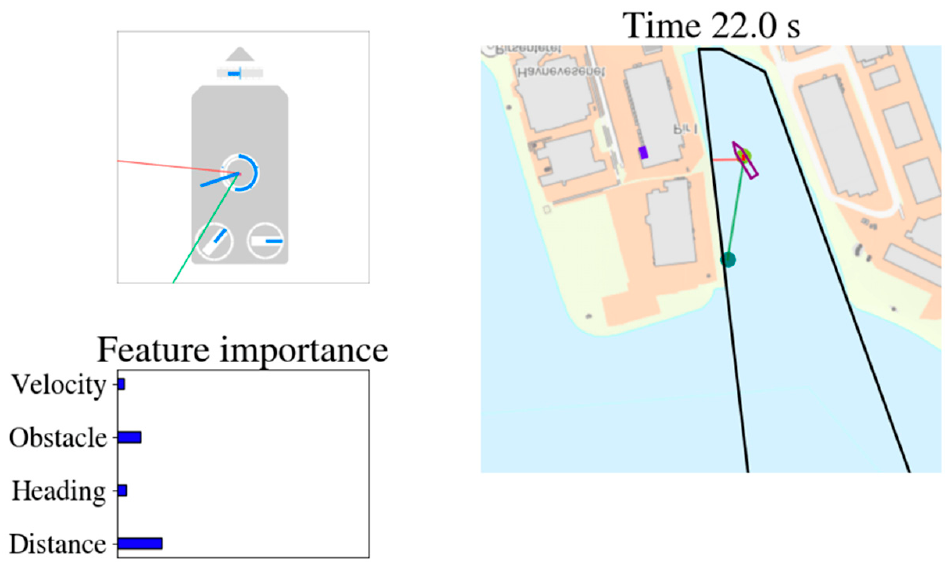
Figure 10. Visualization showing the same information presented in Figure 9 but intended for a ship operator (adapted from [42], image used with permission).